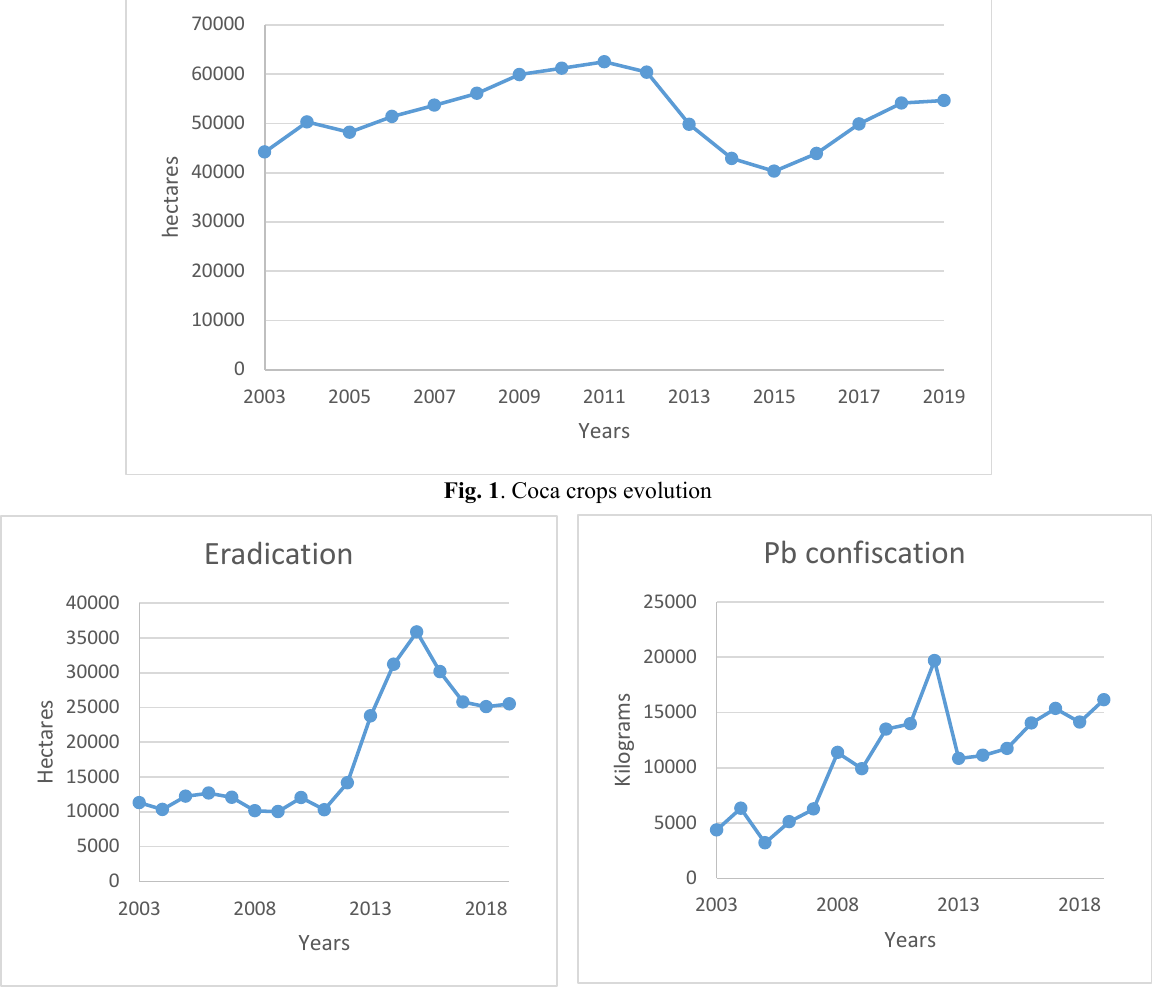
Fig. 1 . Coca crops evolution